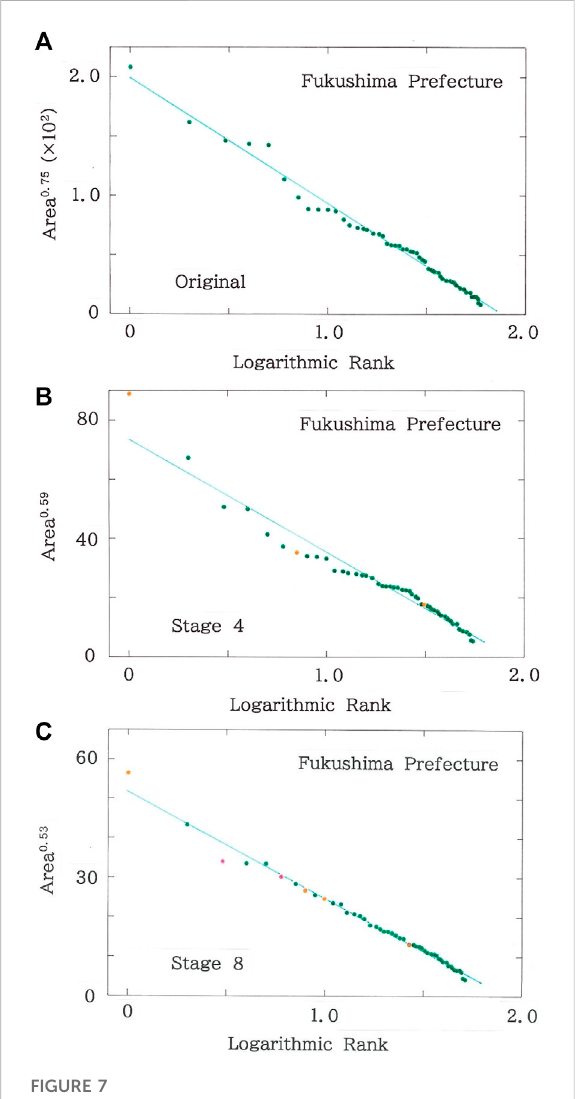
Fukushima Prefecture before consolidation on the logarithmic rank. The blue declining line indicates the optimized fi t (| r | = 0.9938 with d = 0.851 for q = 0.75 and n = 59; a = 1.99×10 2 , b = 1.06×10 2 ). (B) Dependence of the areas (km 2 ) of municipalities in Fukushima Prefecture under consolidations (Stage 4) on the logarithmic rank. The blue line indicates the optimized fi t (| r | = 0.9783 with d = 0.532 for q = 0.59 and n = 55; a = 73.7, b = 38.2). Data of consolidated municipalities are highlighted with orange dots. (C) Dependence of the areas (km 2 ) of municipalities in Fukushima Prefecture after consolidations (Stage 8) on the logarithmic rank. The blue line indicates the optimized fi t (| r | = 0.9943 with d = 1.166 for q = 0.53 and n = 51; a = 51.7, b = 26.9). Data of consolidated municipalities are highlighted with orange and pink dots.